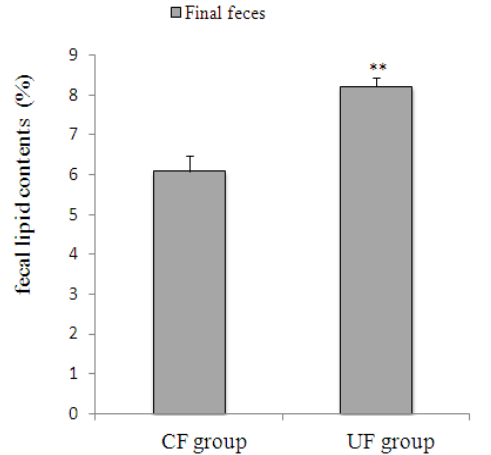
Figure 2. Fecal lipids contents (%) from the feces sampled on the final day of the experiment. The fecal lipids content (% DW) of the feces sampled on the final day of the experiment were significantly greater in the ume fiber (UF) group than in the cellulose (CF) group (p < 0.01) Values are means ± SE (n = 7). The data were analyzed using t -test